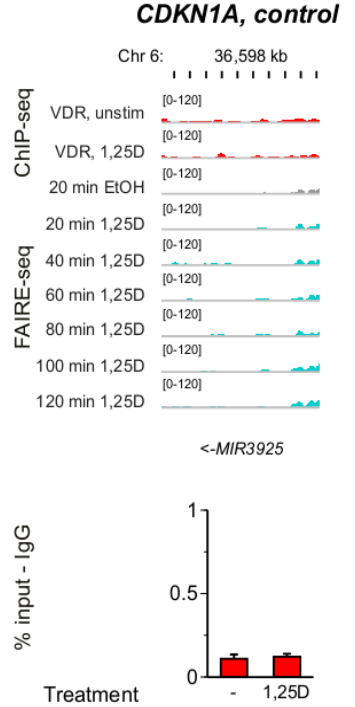
Figure S4. ChIP-qPCR control region. Same setup as in Figure 3 for the control region of the CDKN1A locus was